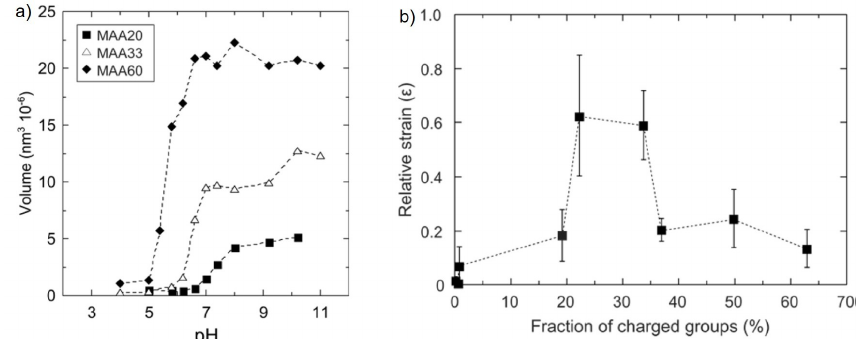
Figure 7. Microgels copolymerised with different amounts of methacrylic acid (MAA): ( a ) Volume of microgels in bulk solution and ( b ) microgel deformability, expressed as relative strain, as a function of the fraction of charged groups within the microgels. Taken from